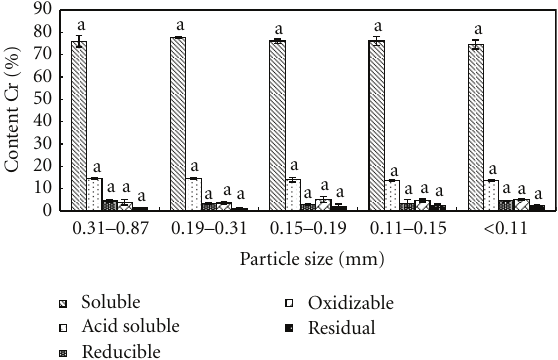
Figure 2: Di ff erent forms of Cr in 5 samples of di ff erent